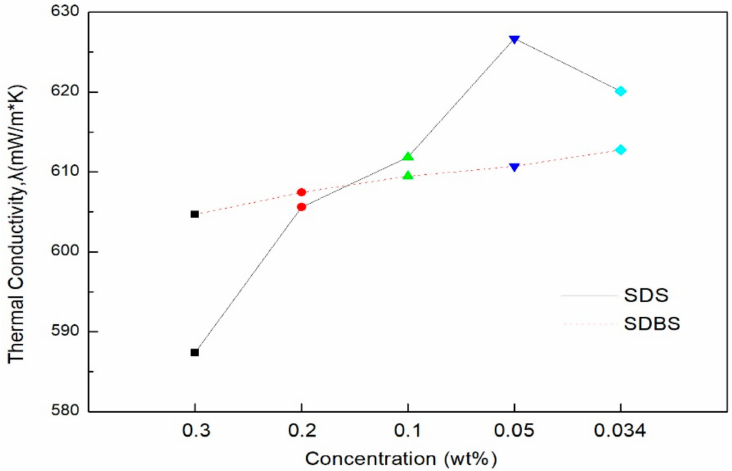
Figure 6. The mean thermal conductivity of graphene nanofluid according to the amount of